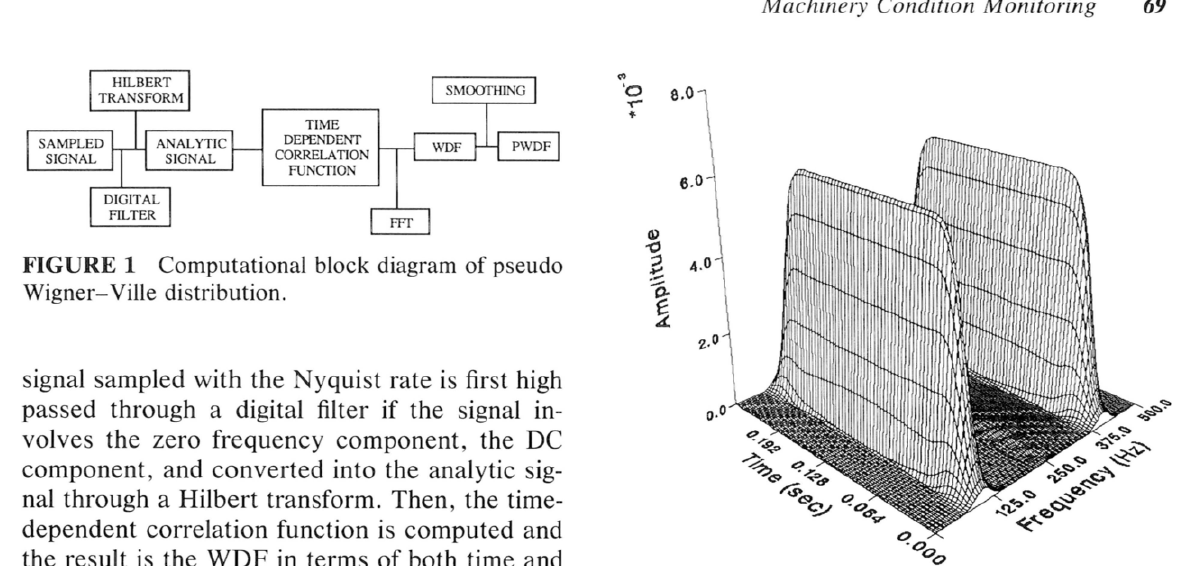
FIGURE 2 Pseudo Wigner-Ville distribution of 100 and 400 Hz pure sine waves. Is = 1000 Hz, N = 256, and smoothing window size = 10 x